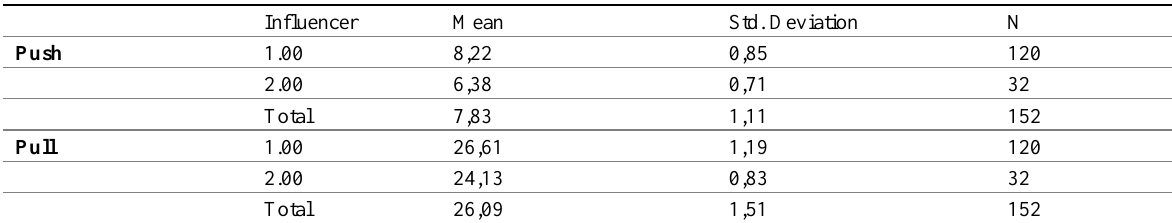
Table 3: Push and pull variables split by WoM and MPP